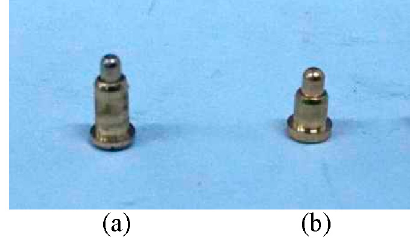
Figure16. Images of the gold-plated electrodes: ( a ) h = 3 mm, d = 1.5 mm; ( b ) h = 2 mm, d = 1.3 mm.